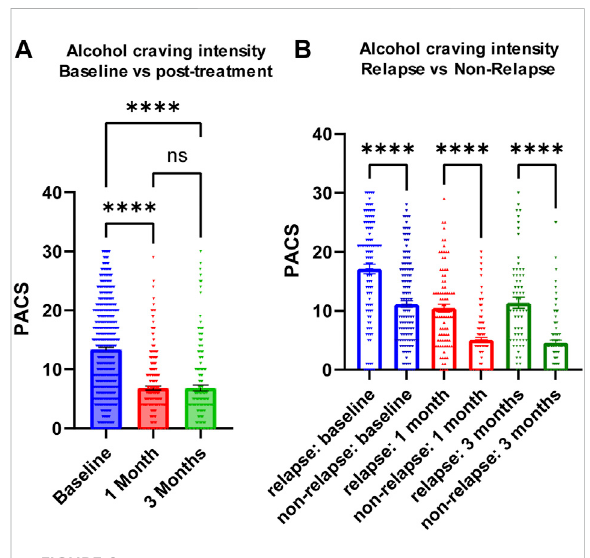
FIGURE 2 Alcohol craving predicts acamprosate treatment response. (A) PACS scores before and after acamprosate treatment for participants in the acamprosate trial ( F (2,923) = 97.81, p < 0.0001). (B) PACSscores weresigni fi cantly higher intherelapsegroup than in the non-relapse group at baseline, 1 month and 3 months after acamprosate treatment ( F (5,685) = 59.73, p < 0.0001). **** p < 0.0001. Relapse was de fi ned as taking one drink during 3